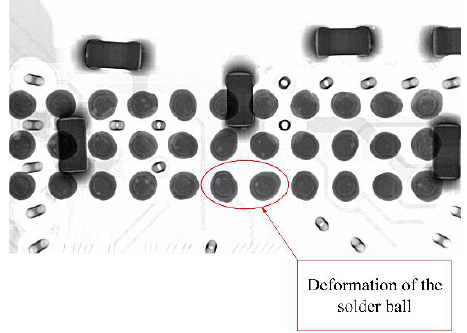
Figure 3. X-ray detection shows the deformation of the solder ball.